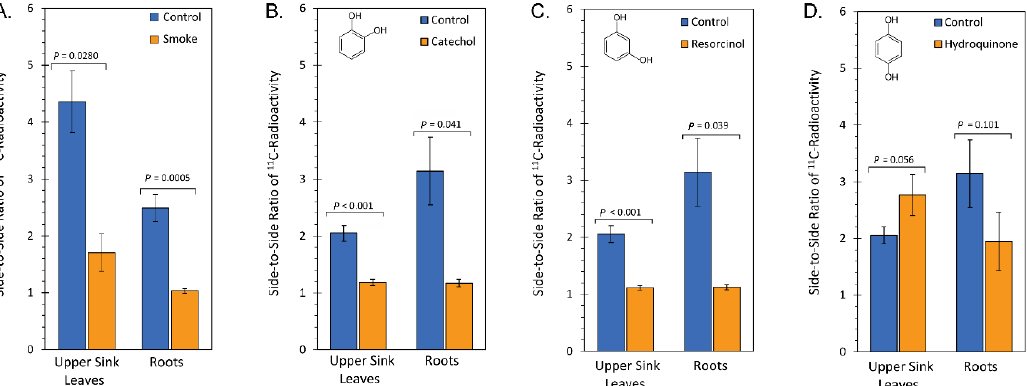
Figure 4. Bar graphs showing changes in vascular sectoriality as a function of treatment. The degree of sectoriality is depicted as the side-to-side ratio of 11 C-radioactivity measured from radiographic images of leaves and roots, ( A ) liquid smoke treatment, ( B ) treatment with catechol, ( C ) treatment with resorcinol, ( D ) treatment with hydroquinone. The midrib of the leaf and taproot were used as the dividing lines for activity measurements using ImageQuant™ TL 7.0 software (Cytiva Life Sciences, Inc., Marlborough, MA, USA) applied to 11 C-radiographs. A value of 1 in the graph reflects no sectoriality. Data represents means ± SE for N = 4 replicates where p < 0.05 were statistically